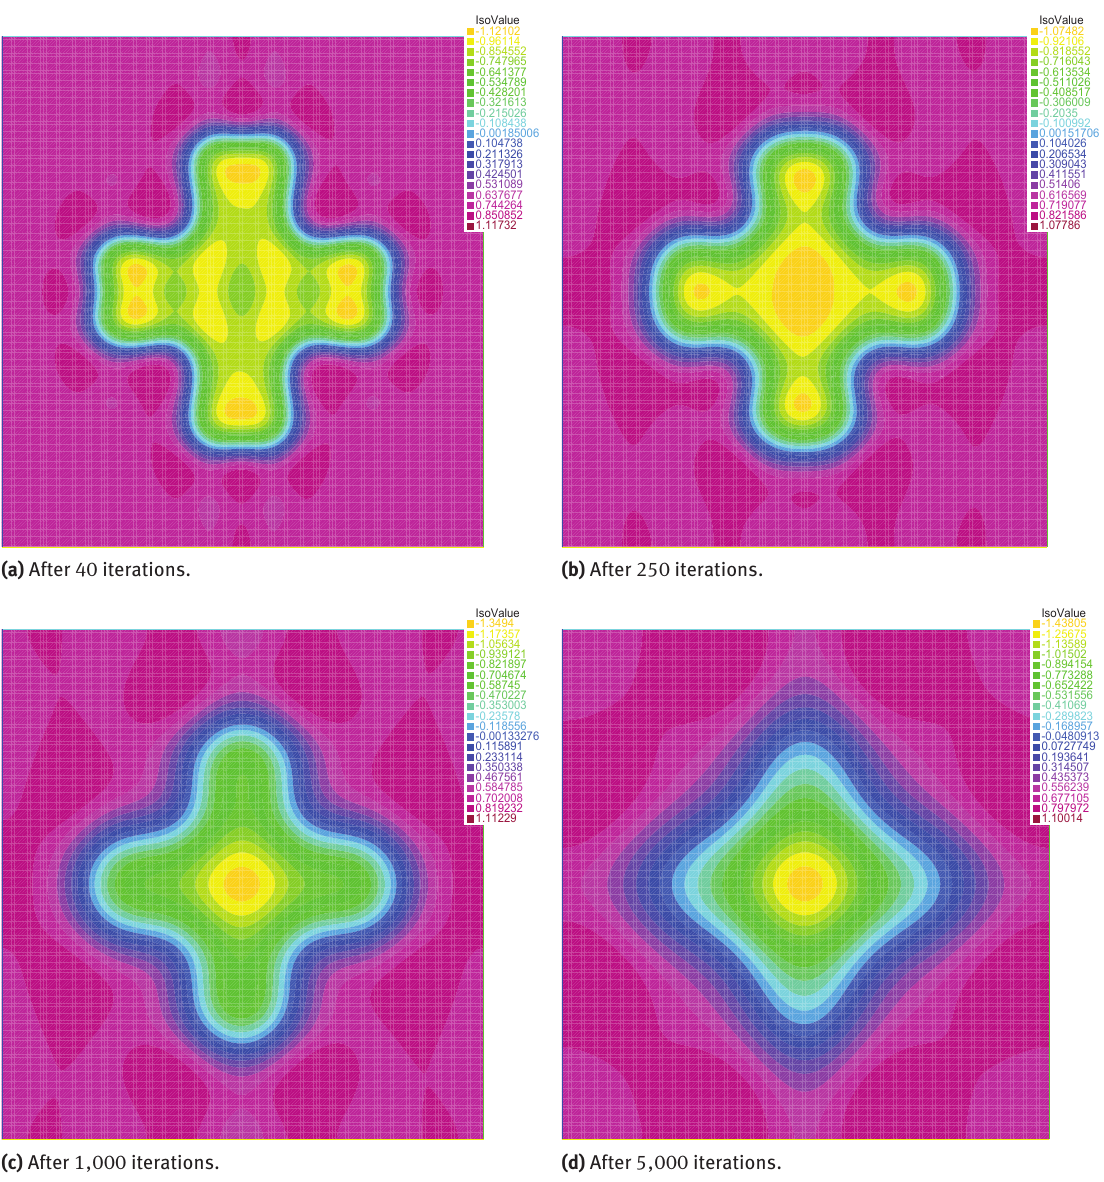
Figure 12: Results for k = 3, dt = 10 − 10